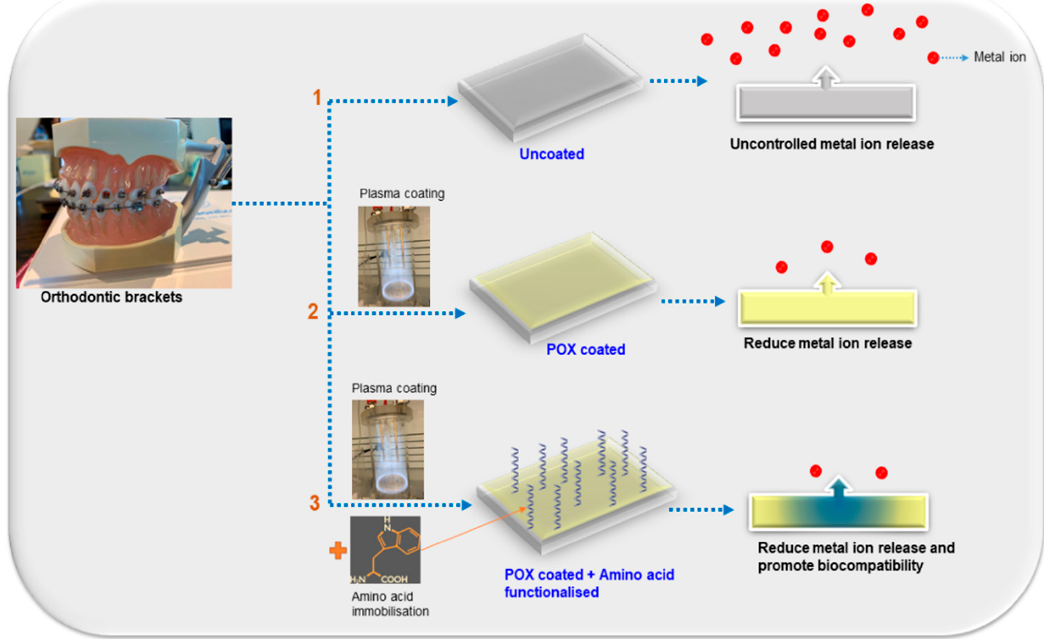
Scheme 1. Schematic illustration of the design of surface-functionalised orthodontic brackets involving plasma coating and subsequent immobilisation with enantiomers of amino acid to combat metal ion release.